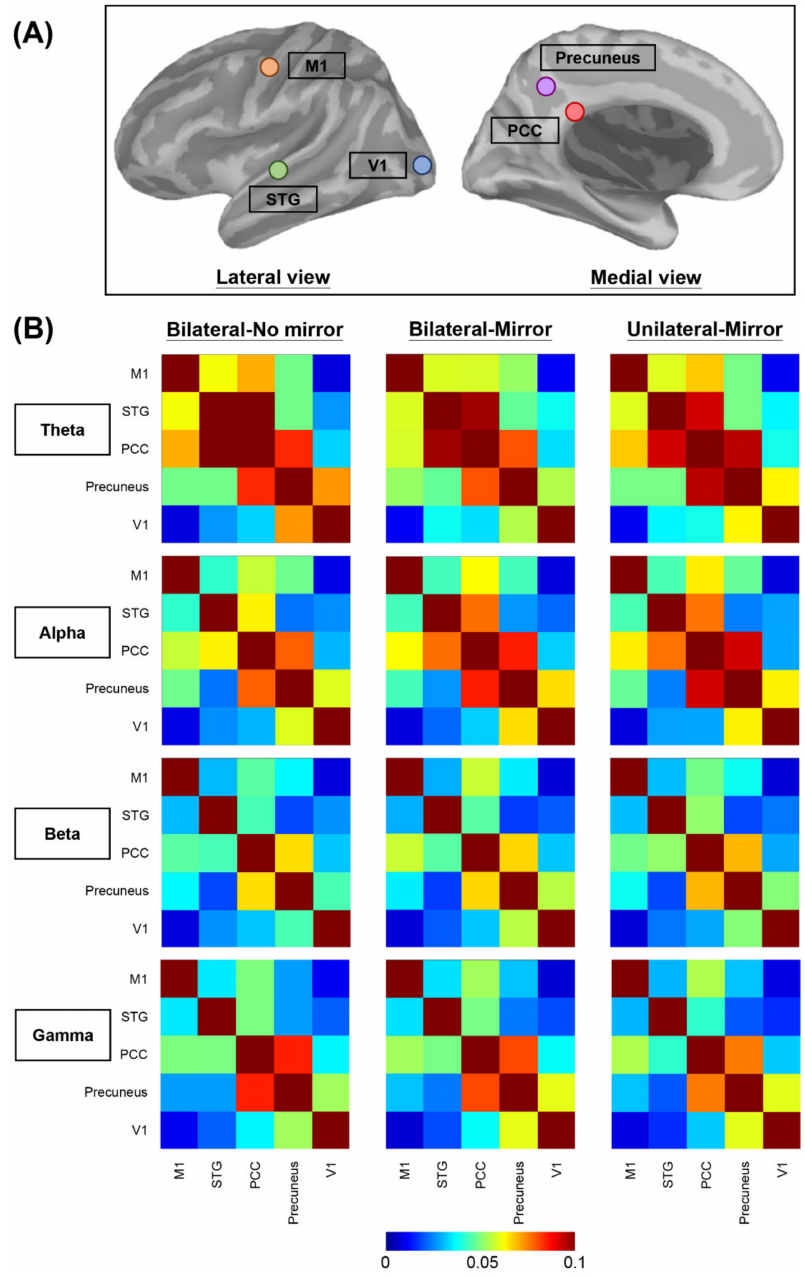
Figure 2. Visualization of the brain connectivity. ( A ) Illustration of 5 brain regions of interest selected for the functional connectivity analysis. ( B ) Averaged functional connectivity matrices among the 5 brain regions of interest in 4 different frequency bands under 3 experimental conditions. Different colors of each grid picture show varying degrees of functional connectivity between each two brain regions. In order to visually present the contrast effect of the relatively small coherence values between different areas in different frequency bands, we presented the color scale using a range of 0–0.1. The original coherence values are demonstrated in the Supplementary Materials. M1—primary motor cortex, PCC—posterior cingulate cortex, STG—superior temporal gyrus, V1—primary visual